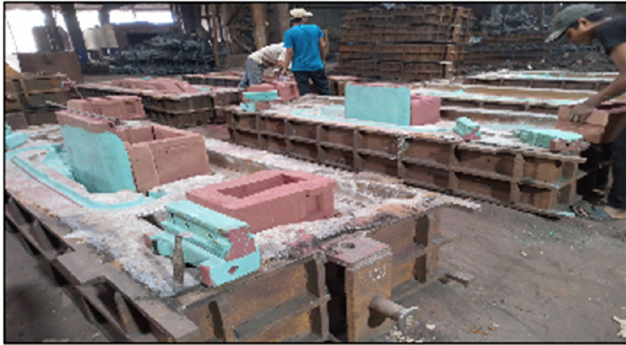
Fig. 8. Current working posture for Core insertion activity TAKT time determination Available data for